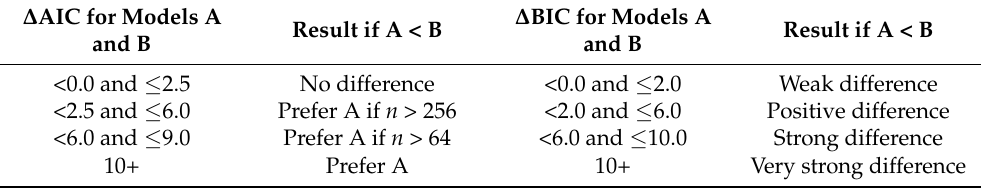
Table 2. Significance levels for AIC and BIC. Source: Raftery, 1995 and Hilbe, 2011. ∆ AIC for Models A